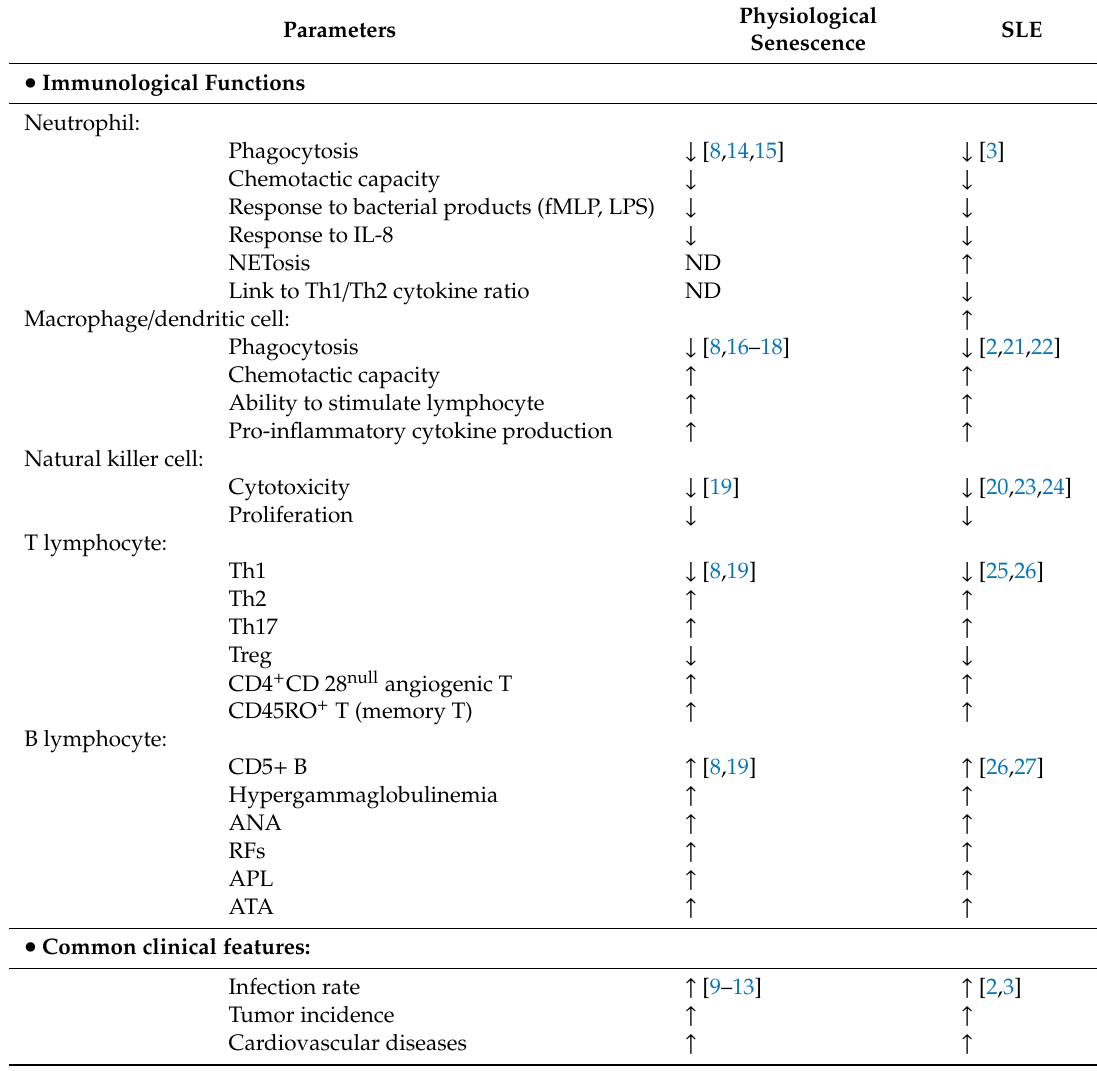
Physiological Senescence